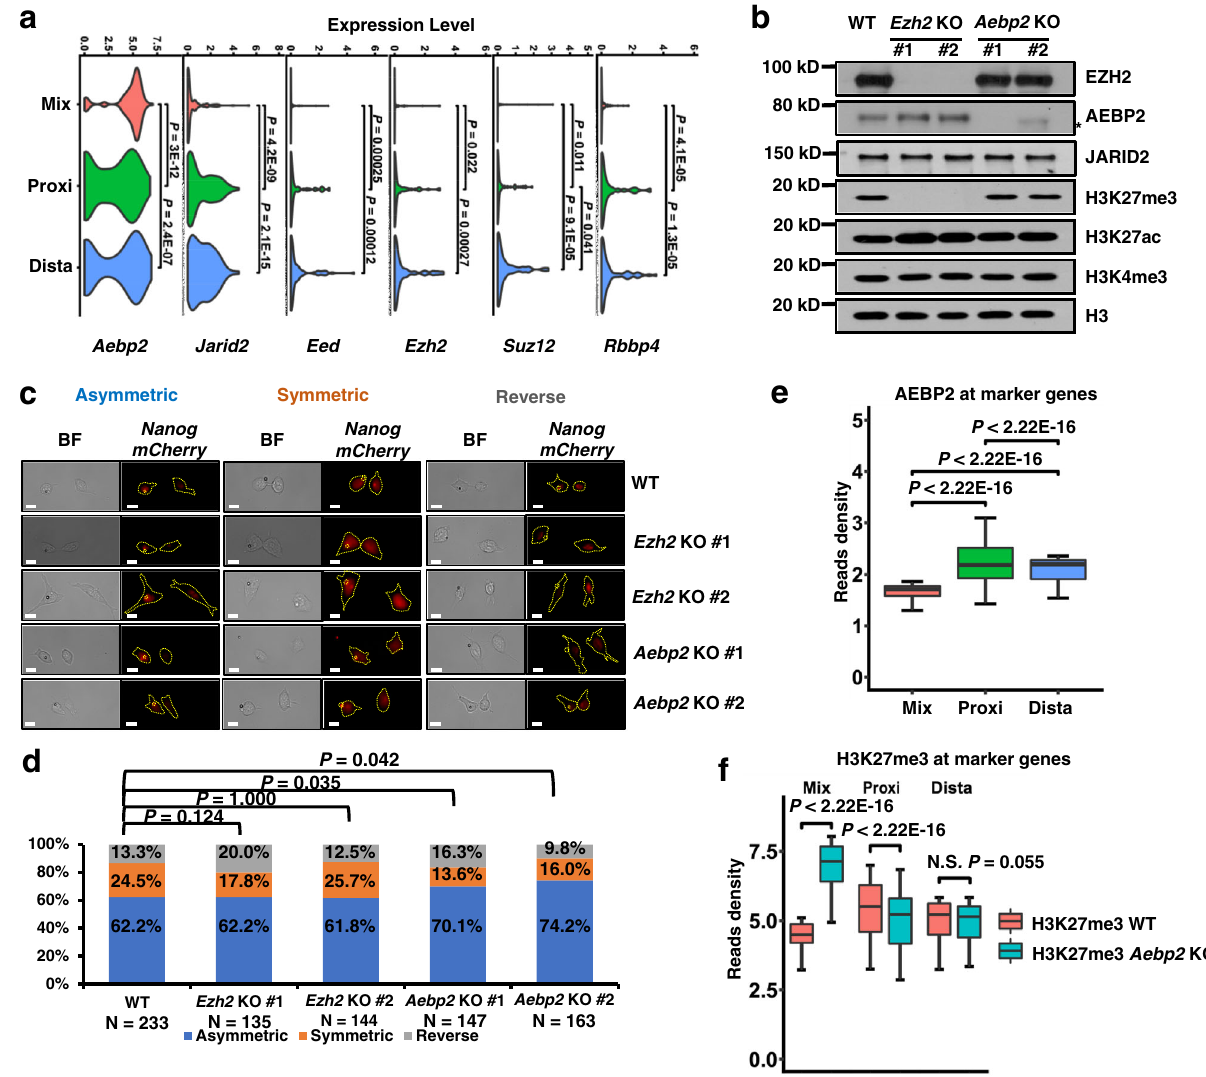
Fig. 6 Aebp2 knockout increases the cells asymmetrically expressing Nanog - mCherry . a Violin plots showing the average expression levels of components of PRC2 in the Mix, Proxi, and Dista clusters. To increase the reproducibility, the gene expressions of H3K27me3 and H3K4me3 scSET-seq were merged for plotting. P values were calculated by Student ’ s t -test, two-sided. Rbbp7 was not detected in the scSET-seq. n = 291 (Mix), 133 (Proxi), and 121 (Dista) cells. b Western blot showing the indicated protein levels in parental and KO mESCs. Ezh2 KO decreased the total levels of H3K27me3 and increased the H3K27ac. Aebp2 KO didn ’ t exhibit obvious effects on the total levels of tested histone marks. Cell extracts were analyzed via Western blotting using the indicated antibodies, and two biological replicates were performed for each blot. Star indicated a nonspeci fi c band. See Supplementary Fig. S14 for the Sanger sequencing results of KO clones. c Representative images of divided Nanog - mCherry mESCs cocultured with Wnt3a beads. Wnt3a beads and cells were marked in the immuno fl uorescence image. Asymmetric, higher mCherry amounts in the bead-proximal cell; Symmetric, similar amounts of mCherry in either cell; Reverse, higher amounts of mCherry in the bead-distal cell. BF, bright fi eld. Scale bar, 15 µ m. d The percentages of asymmetrically, symmetrically, and reversely divided cells, as de fi ned by Nanog - mCherry signals, in parental, Ezh2 and Aebp2 KO cells. P values were calculated by chi-squared test. e The enrichments of AEBP2 at cluster marker genes that were identi fi ed by gene expression. AEBP2 peaks were fi rst called and annotated to the closet transcription starting sites within 20 Kb. The reads density of Aebp2 was then calculated for peaks annotated to each gene. P values were calculated by Student ’ s t -test, two-sided. The boxes were drawn from lower quartile (Q1) to upper quartile (Q3) with the middle line denoting the median, and whiskers with maximum 1.5 IQR (interquartile range). n = 90, 108, and 200 Aebp2 peaks at Mix, Proxi and Dista markers, respectively. n = 1000 (Mix), 1000 (Proxi), and 1000 (Dista) bins of Aebp2 at cluster marker genes. f The enrichments of H3K27me3 at cluster marker genes that were identi fi ed by gene expression. H3K27me3 peaks were fi rst called in WT and Aebp2 KO cells, merged, and annotated to the closet transcription starting sites within 20 Kb. The reads density of H3K27me3 was then calculated for peaks annotated to each gene. P values were calculated by Student ’ s t-test, two- sided. The boxes were drawn from lower quartile (Q1) to upper quartile (Q3) with the middle line denoting the median, and whiskers with maximum 1.5 IQR (interquartile range). n = 504, 243, and 371 H3K27me3 peaks at Mix, Proxi, and Dista markers, respectively. Source data are provided as a Source Data fi